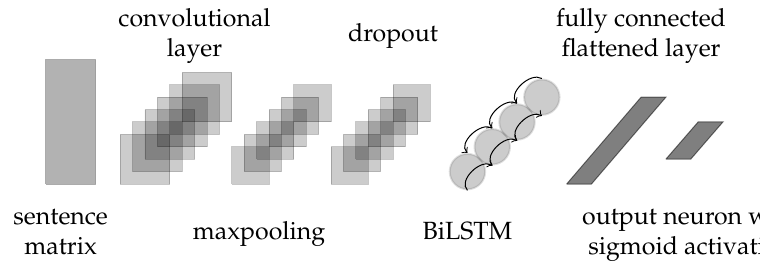
Figure 2. CNN_LSTM network architecture.